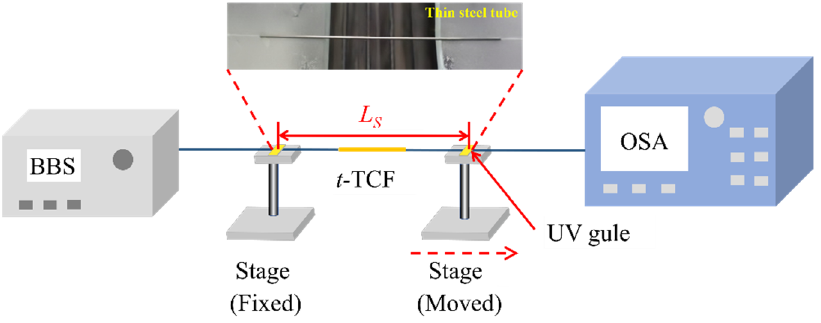
Figure 4. The experimental setup for axial strain sensing.